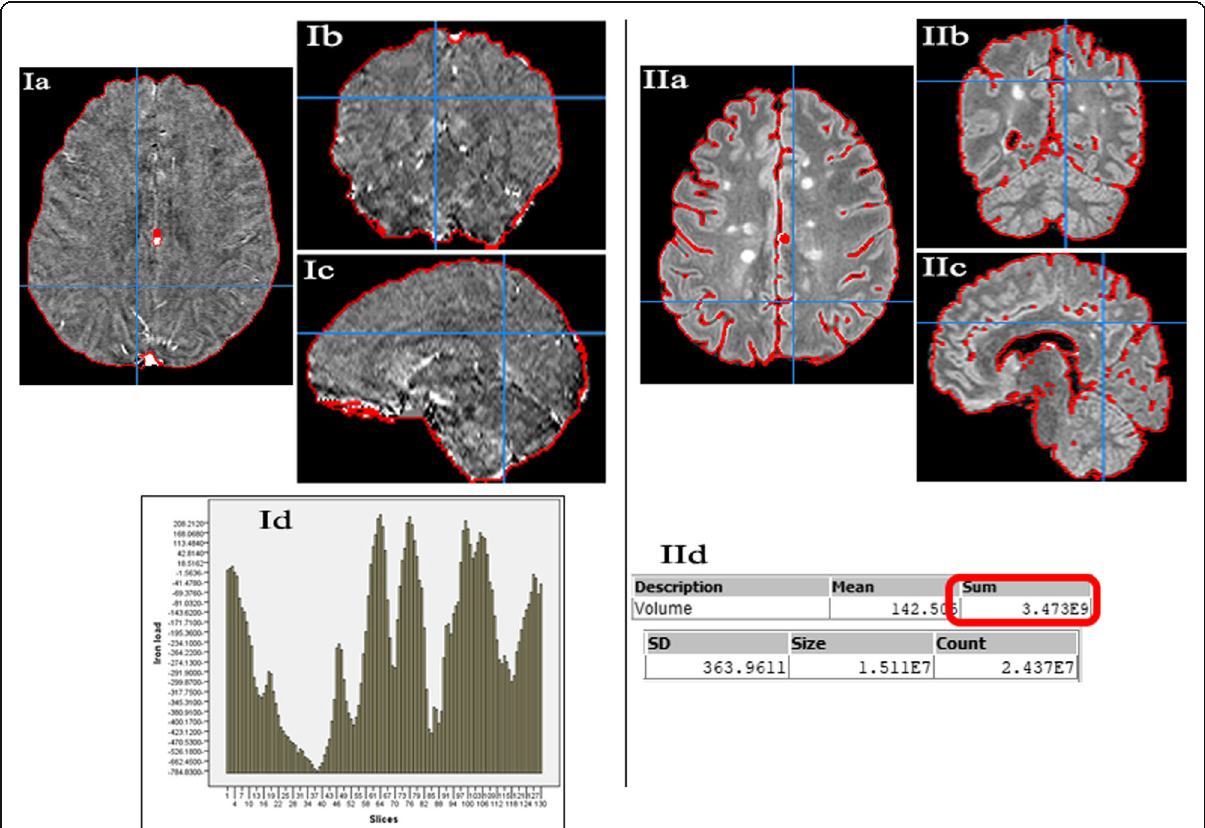
Fig. 2 Measurement of global iron load ( I ) and brain volume ( II ). Ia , Ib , and Ic show the brain selected in quantitative susceptibility maps in axial, coronal, and sagittal views, respectively. Image Id shows the iron load (vertical axis) in 130 slices (horizontal axis) of one subject. The global iron load for each subject was the sum of the iron concentration in the 130 slices. Images IIa , IIb , and IIc show the brain selected in three- dimensional fluid-attenuation inversion recovery series to measure the brain volume. The results of volume analysis for each subject are the mean, sum, standard deviation, size, and count as shown in IId . The sum was the volume of the brain included in the final